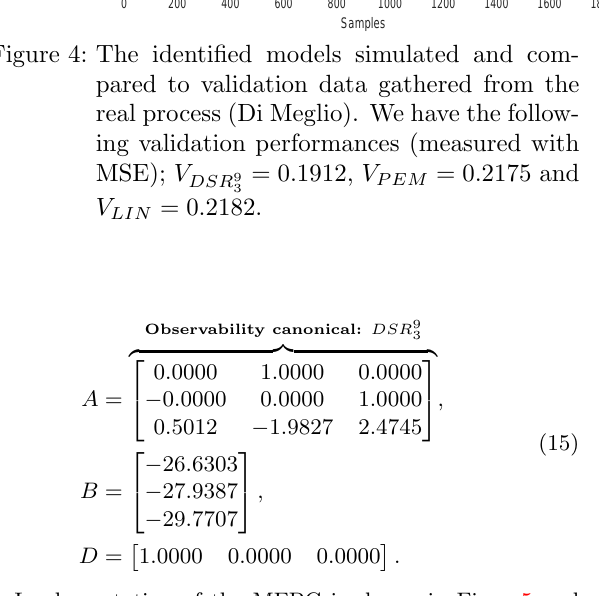
Implementation of the MFPC is shown in Figs. 5 and 10. These figures shows how similar the LQR and MPC strategies